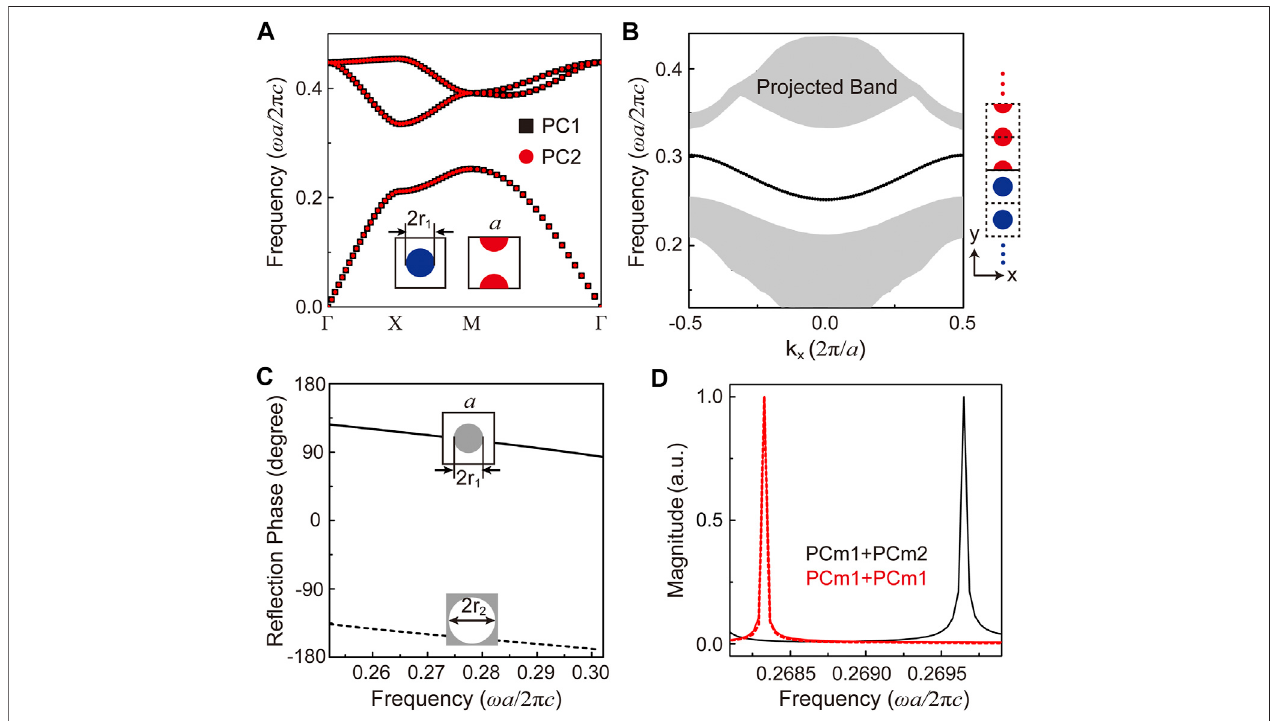
FIGURE 2 | (A) TM photonic band diagrams of PC1 and PC2 with shifted lattice. (B) Calculated projected band structure with a supercell of PC1 and PC2 assembledalongthe y direction.ThefoldedbulkbandsofPC1andPC2arepaintedingray,andtheinterfacestateisinblack. (C) There fl ectionphasesuponPCmirrors. (D) By changing PC mirrors, the cavity mode frequency will change. Red lines indicate the scenario where PCm1 serves as both cavity mirrors, and the black line indicates the scenario where PCm1 and PCm2 serve as the two cavity mirrors, respectively. A slab of effective parameters ε (cid:1) − 2.8 and μ (cid:1) 1.2 with a re fl ection phase 113.578 ° is also considered to replace PCm1, whose re fl ection phase is the same as that of PCm1 at 0.2683 c/a